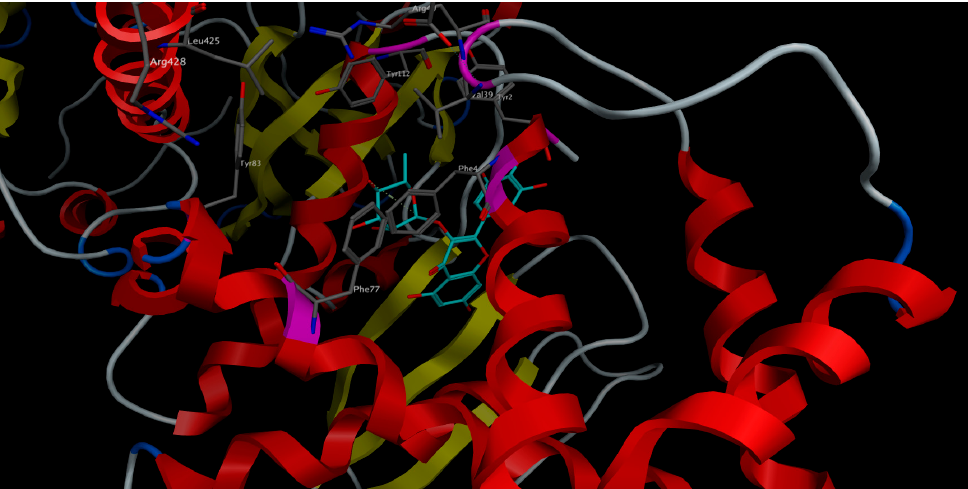
Figure 6. 3D-interactions of myricitrin upon docking into the stimulators binding site in sGC-activated receptor state.